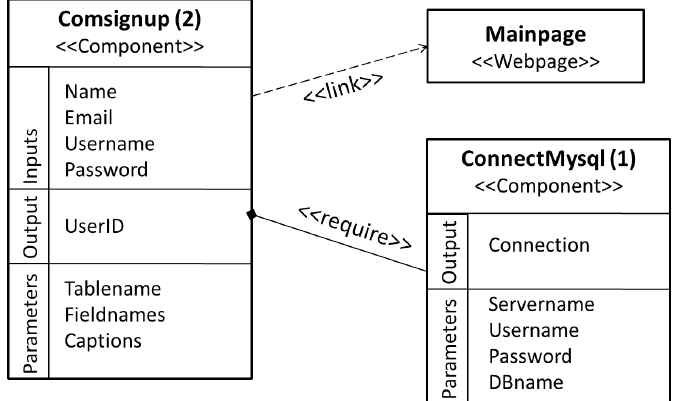
Figure 7. CPIM for sign up component.